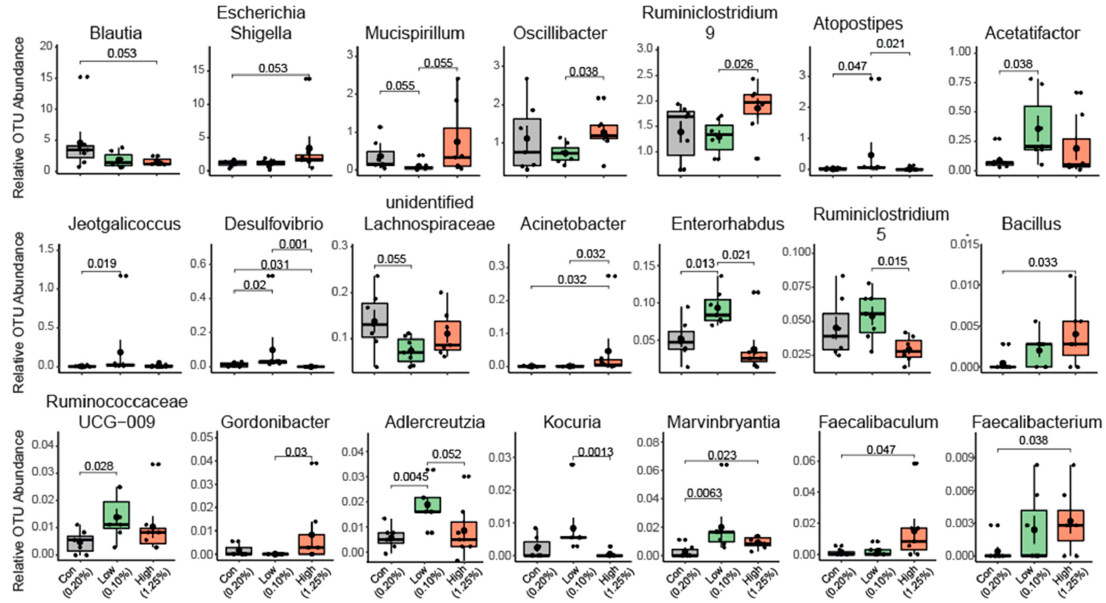
Figure 5. Change in composition of the gut microbiota at the genus level in animals fed with control diet ( n = 7), TRP- deficient diet ( n = 7), and TRP-rich diet ( n = 7). Total of 21 genera were found to be different between at least one comparison (con vs. TRP-def/low, con vs. TRP-high, TRP-def/low vs. TRP high) The data represent OTUs of certain genera found to be different among the groups (data are expressed and mean +/ − SE and l p -values were calculated using the Kruskal Wallis test).